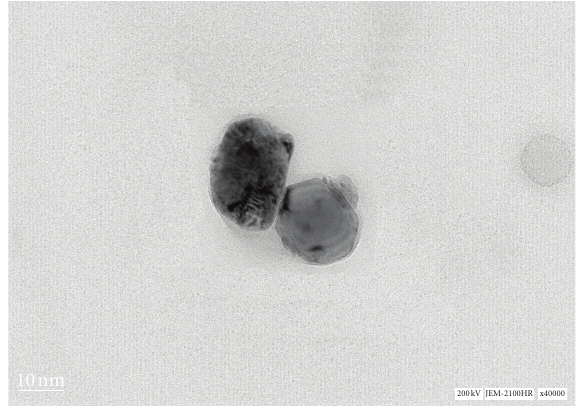
Figure 3: The TEM images of 5wt% Fe/TiO 2 nanocomposites prepared by deposition-precipitation method.